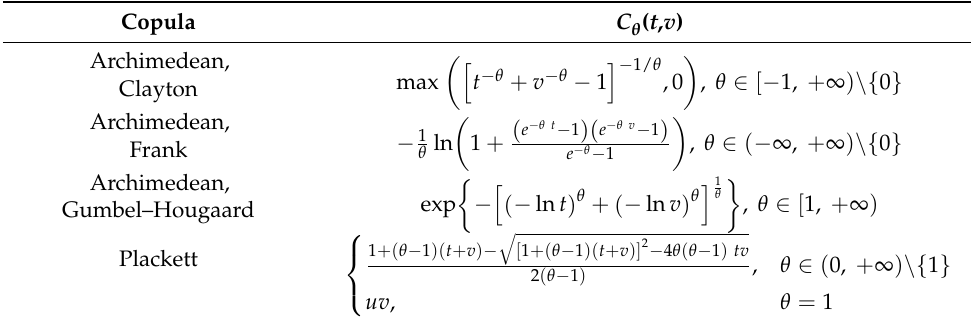
Table 2. Selected copulas C θ ( t , v ) [based on